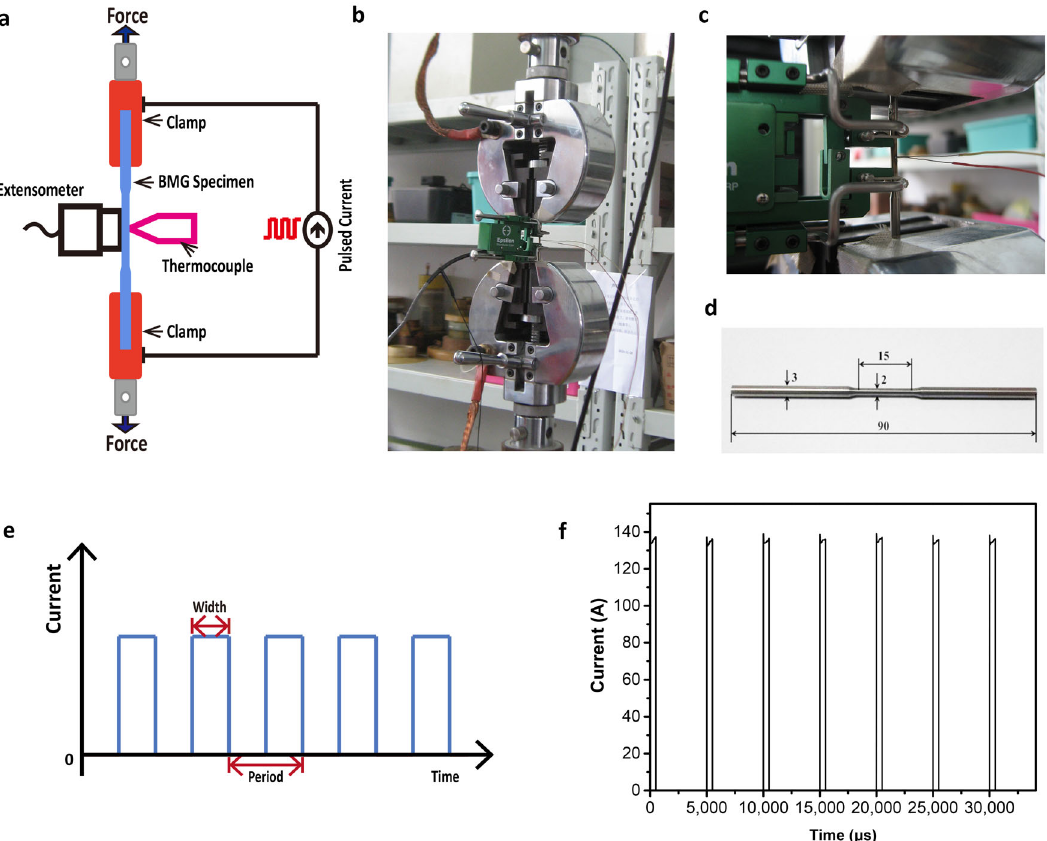
Fig. 1 The experimental scheme of tensile tests on Zr 55 Cu 30 Al 10 Ni 5 (Zr55) bulk metallic glass (BMG) with pulsed electric current applied to the BMG specimen. a Schematic illustration of the experimental setup; b actual experimental setup, and c close-up on the BMG specimen, the thermocouple, and the extensometer; d geometry of the BMG specimen for tensile test; e illustration on the pattern of the current pulses adopted, a square wave; f an example of the current pulses actually generated, a square wave with a pulse width of 0.5 ms, and a pulse period of 5